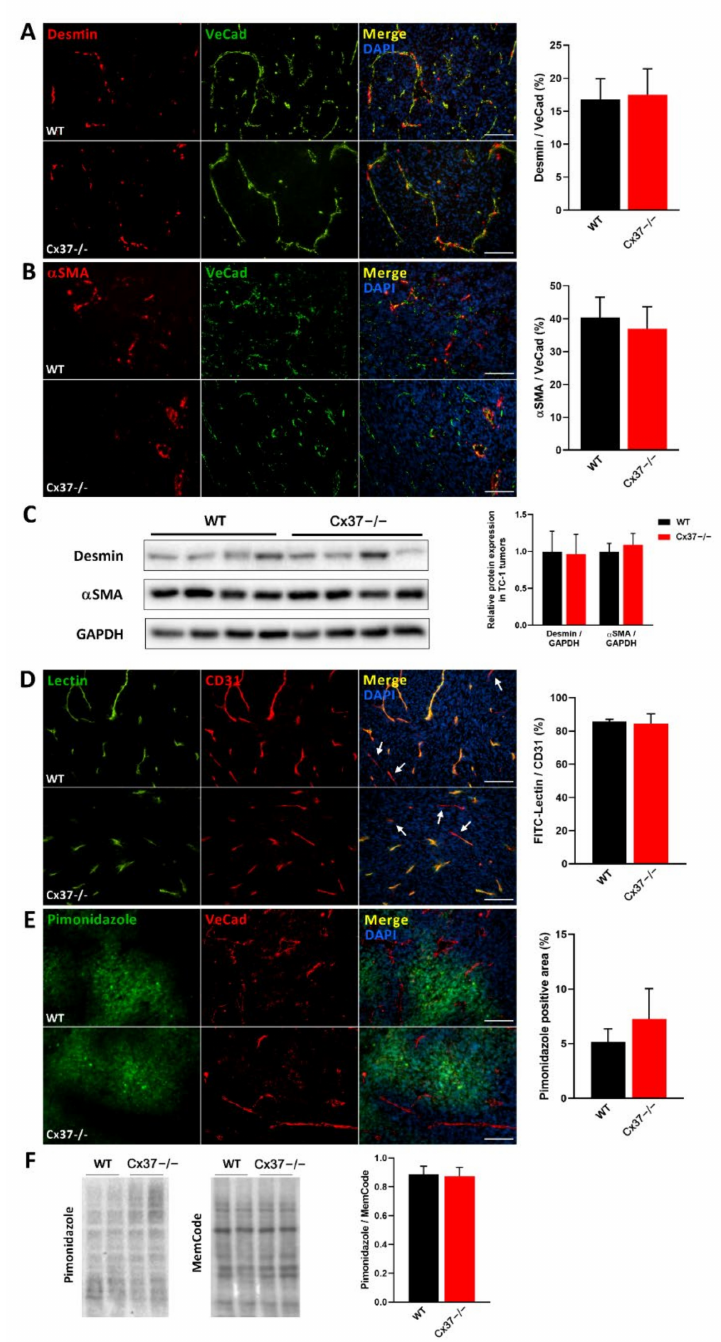
Figure 4. Loss of Cx37 does not alter the maturation of vessels in TC-1 tumors. ( A , B ) Left panels: immunostaining of desmin ( A ) and alpha-smooth muscle actin ( α SMA; ( B )) shows the mural cells which surrounded VeCad-positive EC in the newly formed vessels of TC-1 tumors. Right panels: The right bar graphs show that the coverage of vessels by mural cells was similar in the tumors grown in Cx37 − / − and WT mice. Data are mean + SEM of 8–15 fields, from at least 5 mice per group. Bars = 100 µ m. ( C ) Western blots confirmed that the tumors grown in Cx37 − / − and WT mice